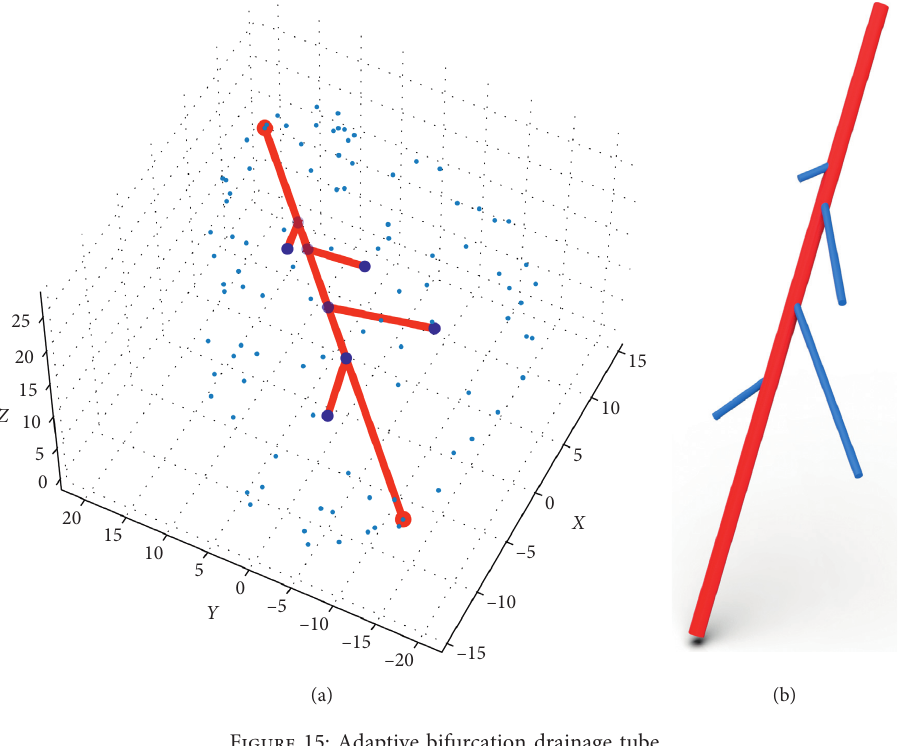
Figure 15: Adaptive bifurcation drainage tube.